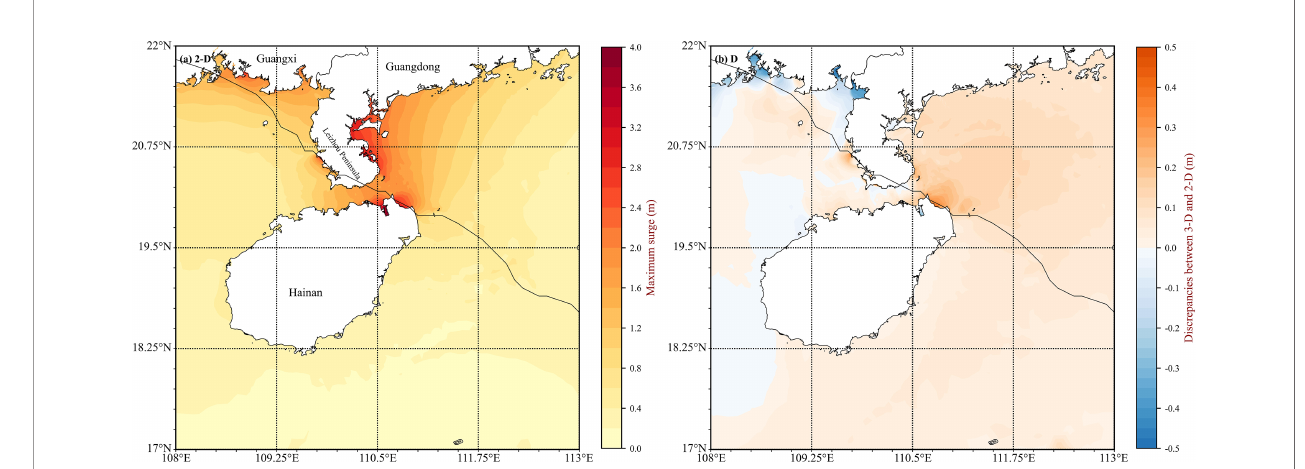
FIGURE 8 | Spatial distributions of (A) peak surge (m) for the 2-D model and (B) the peak surge differences between the 3-D and 2-D models.